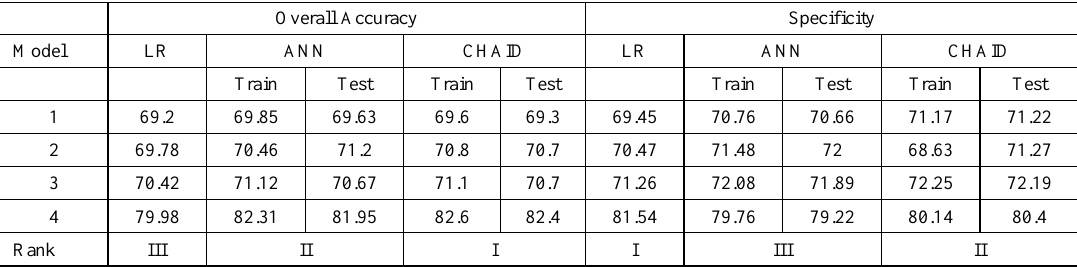
Table 9. Performance evaluation of Logistic, ANN and decision tree models